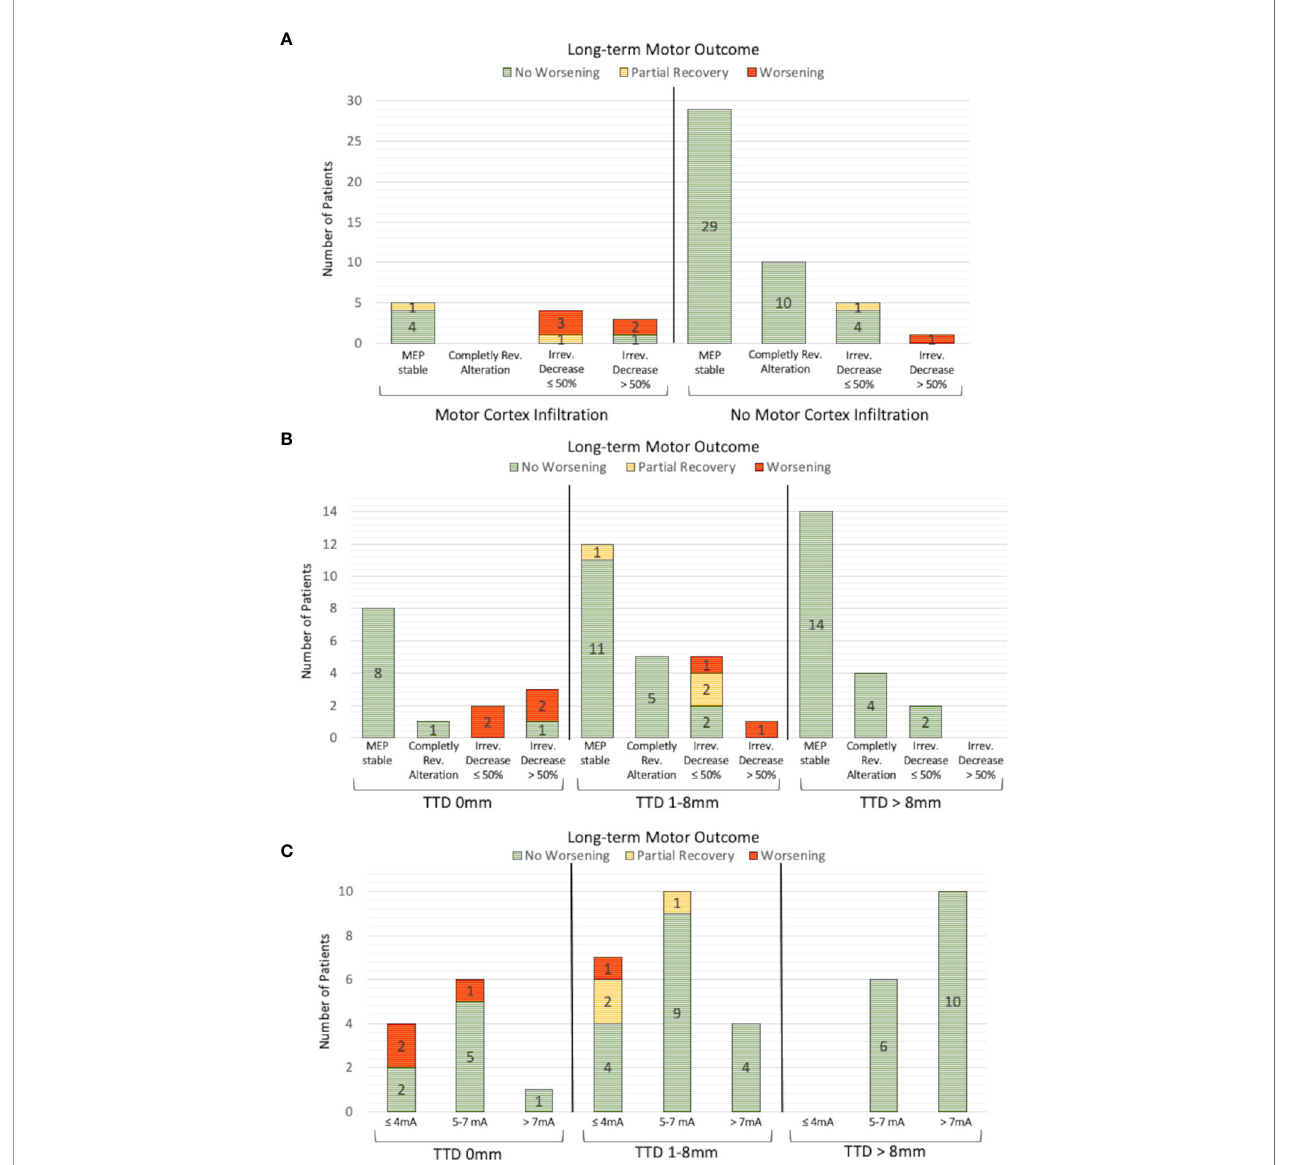
FIGURE 3 | Analysis of IOM and long-term motor outcome. An irreversible MEP amplitude decrease >50% resulted in worse motor outcome in 3 of 4 patients (A) . An irreversible MEP amplitude decrease ≤ 50% resulted in a new postoperative motor de fi cit, particularly in patients with nTMS-veri fi ed motor cortex in fi ltration, that was not present in patients without motor cortex in fi ltration. A similar correlation could be found for the analysis of the TTD (B) . No patient with a TTD >8mm suffered a new motor de fi cit, independently of whether MEP changes were detected or not. The motor outcome of patients with an irreversible MEP decrease ≤ 50% is worse, especially in patients with a TTD of 0mm than in patients with a TTD between 1 and 8mm. This phenomenon is also observed for the minimum SCS intensity, where the postoperative motor outcome was worse in the group of patients with a TTD of 0 mm than in the group with a TTD between 1 and 8mm, while the same SCS intensities were used (C)